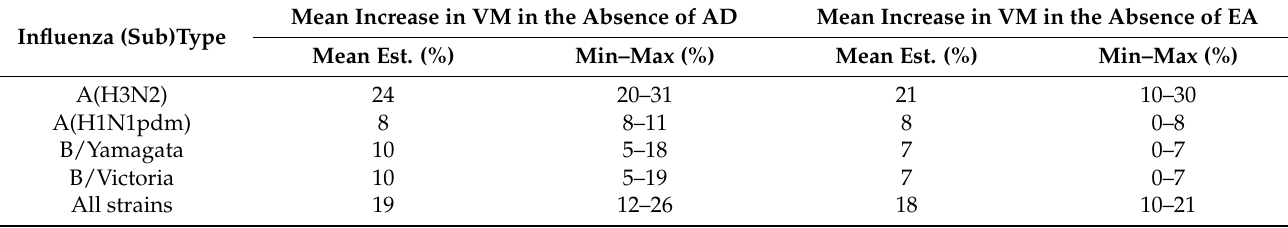
Table 1. Expert estimates of the absolute increase in vaccine match in the absence of antigenic drift or egg adaptation changes, per influenza (sub)type, at the EU5 level, between 2014 and 2019. Influenza (Sub)Type